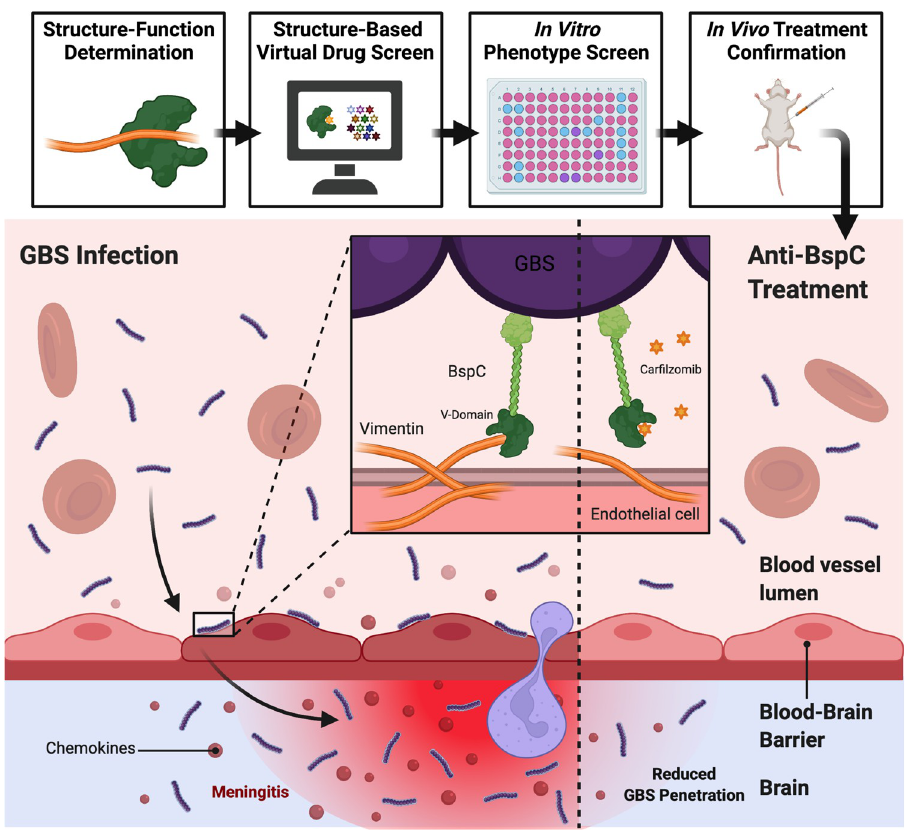
Fig 8. Summary of Anti-BspC Treatment to Reduce the Pathogenesis of GBS Meningitis. GBS utilizes BspC to interact with vimentin expressed by endothelial cells to adhere to the BBB endothelium and cause meningitis. Site- directed mutagenesis identified a vimentin-binding pocket contained within the BspC V-domain. This structure- function determination informed a virtual drug screen that yielded a list of drugs, two of which were confirmed to block BspC dependent adherence brain endothelial cells in vitro . Of these drugs, Carfilzomib was the most effective and was also able to prevent GBS entry into the brain in vivo . Figure generated using BioRender.